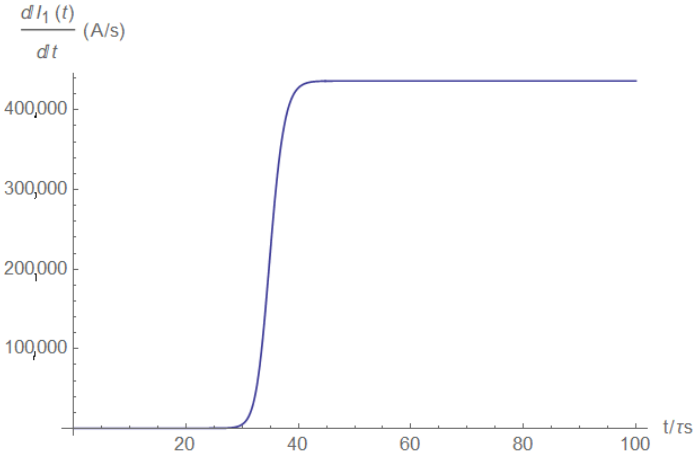
Figure A19. The source current derivative.